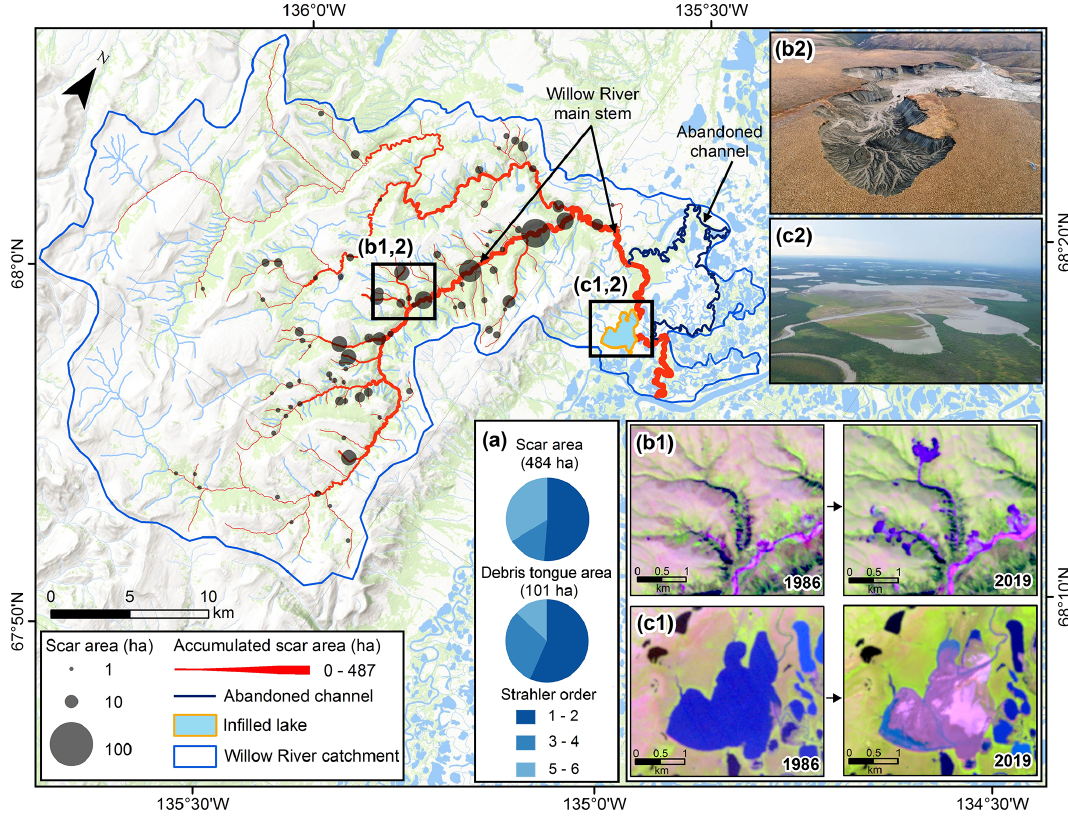
Figure 6. The main map shows thaw-driven landslide impacts on the fluvial network of the Willow River (Mackenzie Delta) area. Red lines along the drainage network highlight impacted stream segments, weighted by cumulative landslide scar area (ha), and the downstream accumulation of impacts through the fluvial system. The grey proportional circles indicate the total landslide scar area > 1ha per affected stream segment, including retrogressive thaw slumps as well as shallow and deep translational slides. The abandoned channel is shown in dark blue. Boxes on the map labeled (b1, b2) and (c1, c2) indicate inset imagery and photographs. (a) The scar and debris tongue area- weighted distribution of landslide impacts by Strahler order within the Willow River fluvial network. (b1) Landsat images (7 July 1986 and 27 July 2019) indicating increases in thaw-driven landslide erosion since the late 1990s and (b2) corresponding oblique aerial photograph of the largest thaw slump within the Landsat plate. (c1) Landsat images for the same dates show the lake before and after infilling and delta development where Willow River rerouted in 2007–08 into Willow Lake. (c2) Oblique photograph of the alluvial deposit. Landsat images are false color composites of multispectral bands; R is shortwave infrared, G is near infrared, and B is green. The base map is from ESRI ArcGIS